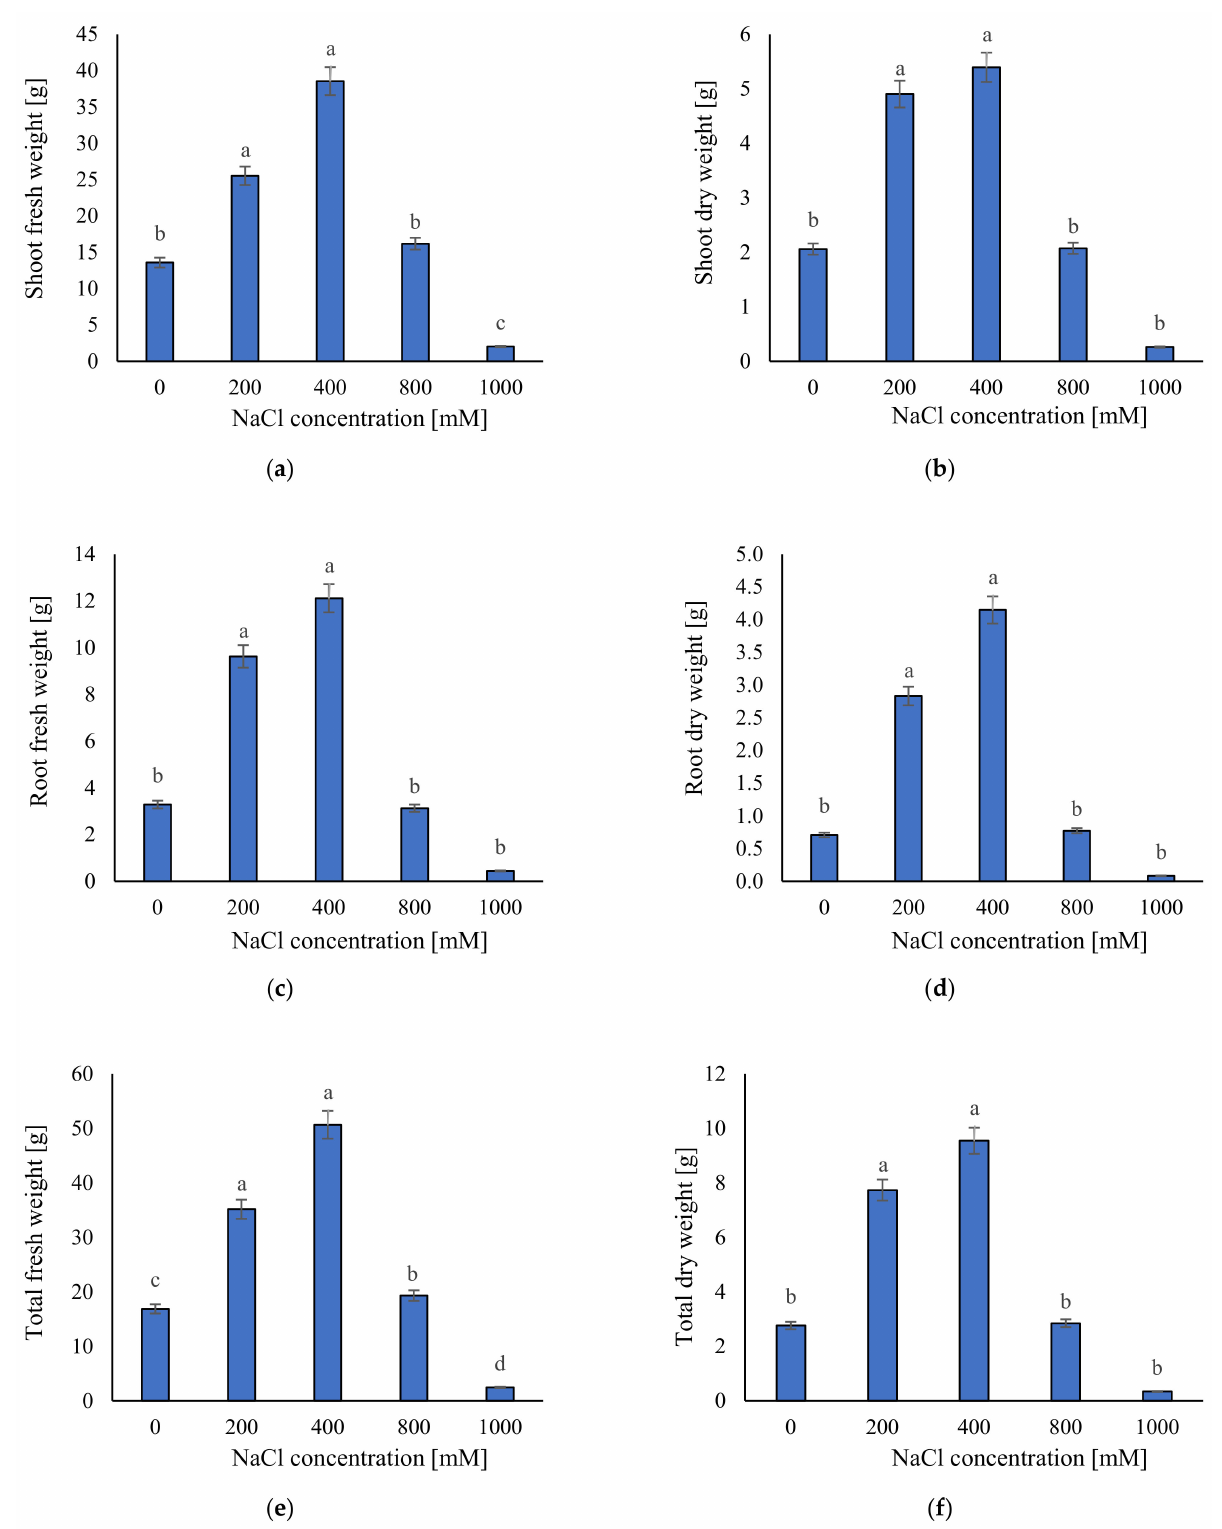
Figure 3. The average parameters of: ( a ) shoot fresh weight; ( b ) shoot dry weight; ( c ) root fresh weight; ( d ) root dry weight; ( e ) total fresh weight; and ( f ) total dry weight in the tested plants; ± SD in the tested samples. ANOVA p < 0.001, significant differences based on post hoc Tukey’s test are marked with different